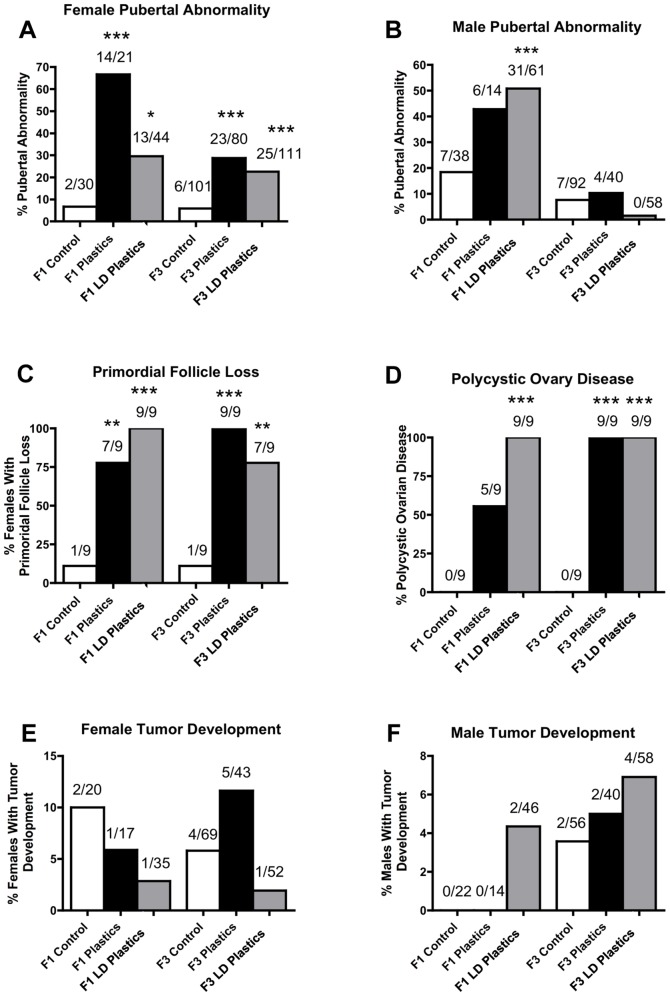
Pubertal abnormalities, primordial follicle loss, polycystic ovary disease and tumor development from control, plastics, or lower dose(LD) plastics (BPA, DEHP and DBP) lineages. Percentages of females (panel A) and males (panel B) with pubertal abnormalities, or those females with primordial follicle loss (panel C) or polycystic ovary disease (panel D), and tumor development in females (panel E) and males (panel F) in F1 and F3 generations are presented. The actual number of diseased rats/total number of rats in each group are shown above the respective bar graphs (* P<0.05; ** P<0.01; *** P<0.001).